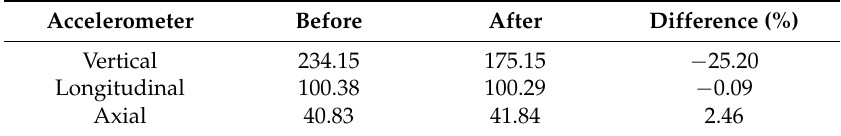
Table 2. The spectral power values for each accelerometer before and after wheel intervention.